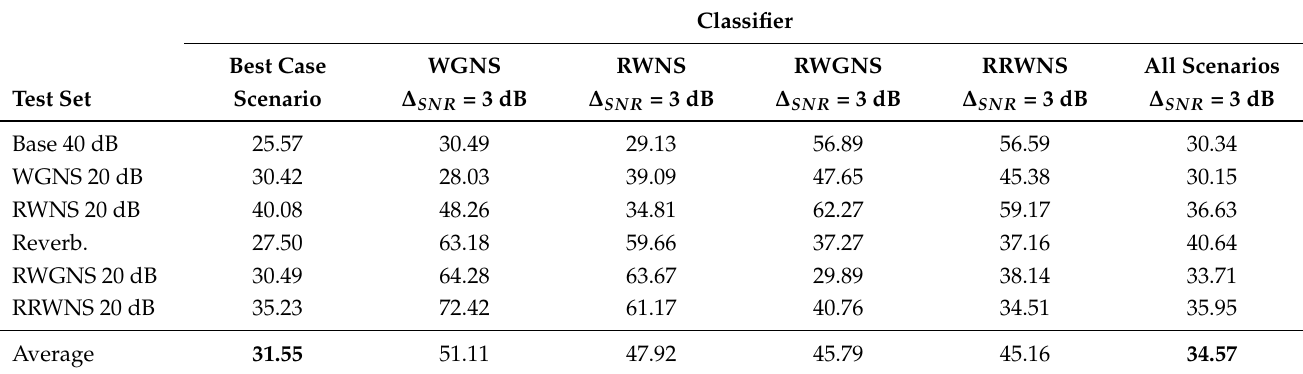
Table 6. Third stage experiments results. Error probability (%) cross results within different noises databases (Emo-DB).